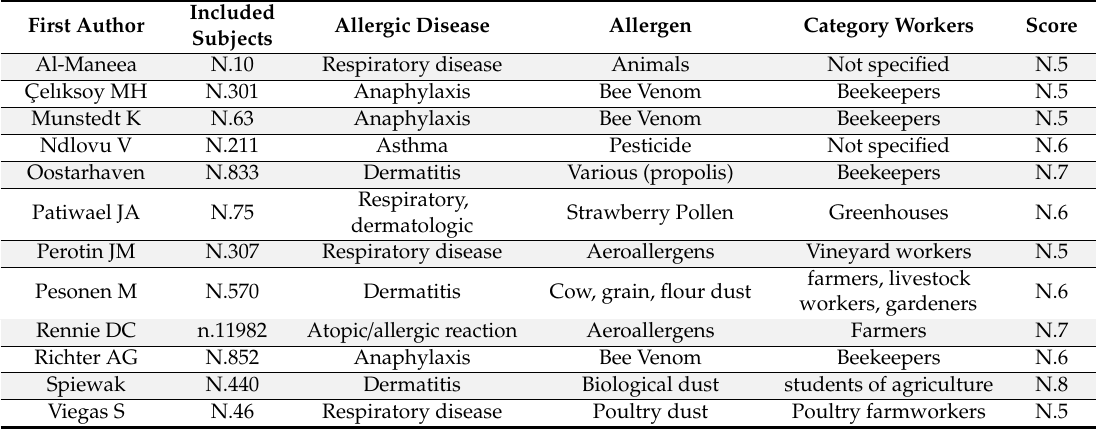
Table 3. Cross articles that were included, together with their relative scores, in alphabetical